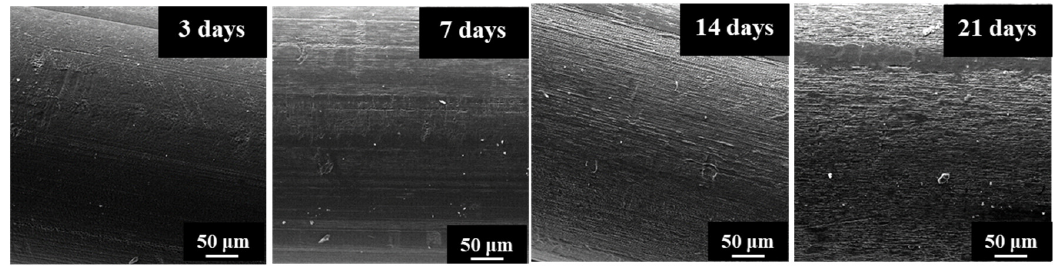
Figure 5. SEM micrographs showing the progressive surface erosion of P4HB sutures exposed to the Rhizopus oryzae medium at 37 °C for 3, 7, 14, and 21 days.